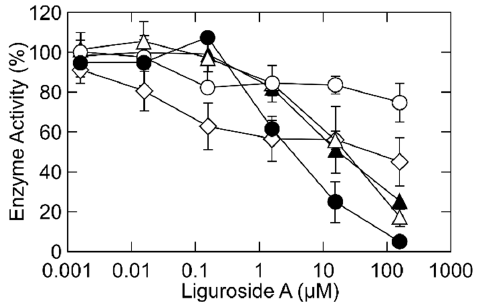
Figure 6. Inhibition of various lipoxygenase and cyclooxygenase activities by liguroside A. Reactions were carried out under the standard conditions in the presence of liguroside A at various concentrations and the products were quantified, using a reverse-phase HPLC. Relative enzyme activities of the triangles), as compared to the activity without inhibitors, are shown. 15-lipoxygenase-1 (closed circles), platelet-type 12-lipoxygenase (open circles), 5-lipoxygenase (open lozenges), cyclooxygenase-1 (open triangles), and cyclooxygenase-2 (closed triangles), as compared to the activity without inhibitors, are